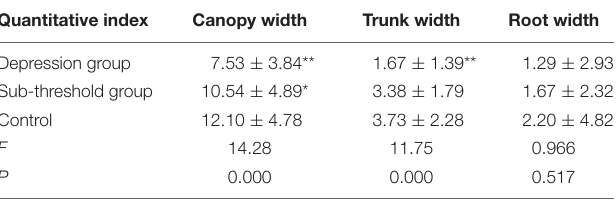
FIGURE 5 | Percentage of canopy, trunk, and root height in the total height. The differences were not statistically significant ( p > 0.05, one way ANOVA). TABLE 3 | Canopy, trunk, and root width (cm) in the groups.